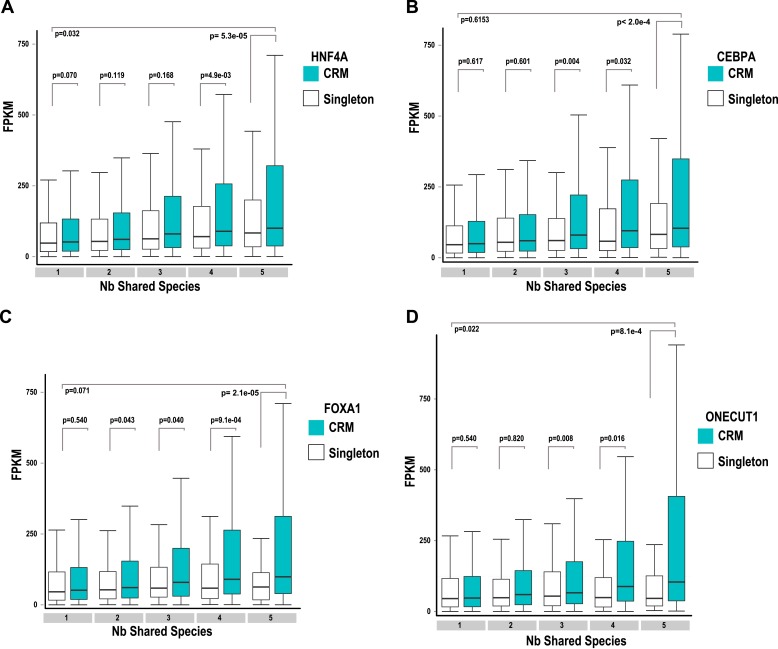
Association of shared TFs in CRMs and Singletons with human gene expression obtained by RNA-seq in human liver (Kutter et al., 2011; E-MTAB-424) broken down by the transcription factor in the CRM: (A) HNFA; (B) CEBPA; (C) FOXA1 and (D) ONECUT1.TFs in CRMs or singletons were assigned to the nearest gene and the FPKM (Fragments Per Kilobase of exon per Million reads) was recorded for CRMs and TFs broken down by transcription factor. Adjusted p-values are shown and like Figure 5, the CRMs were associated with more highly expressed genes in the 5-way and 4-way–shared categories.